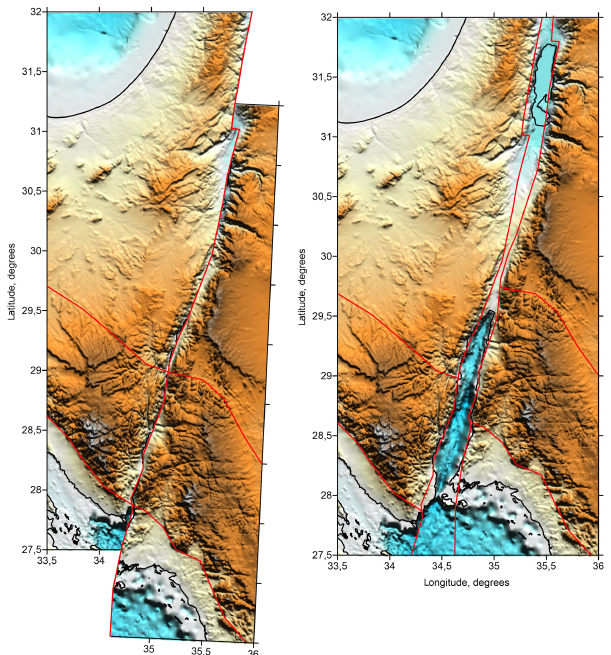
Figure 10. Back-reconstruction of the displacements along the DST since the initiation in the early Miocene (left) (Eyal et al., 1981) and present topography along the DST. Red lines mark the main structures at the initial stage for reference.